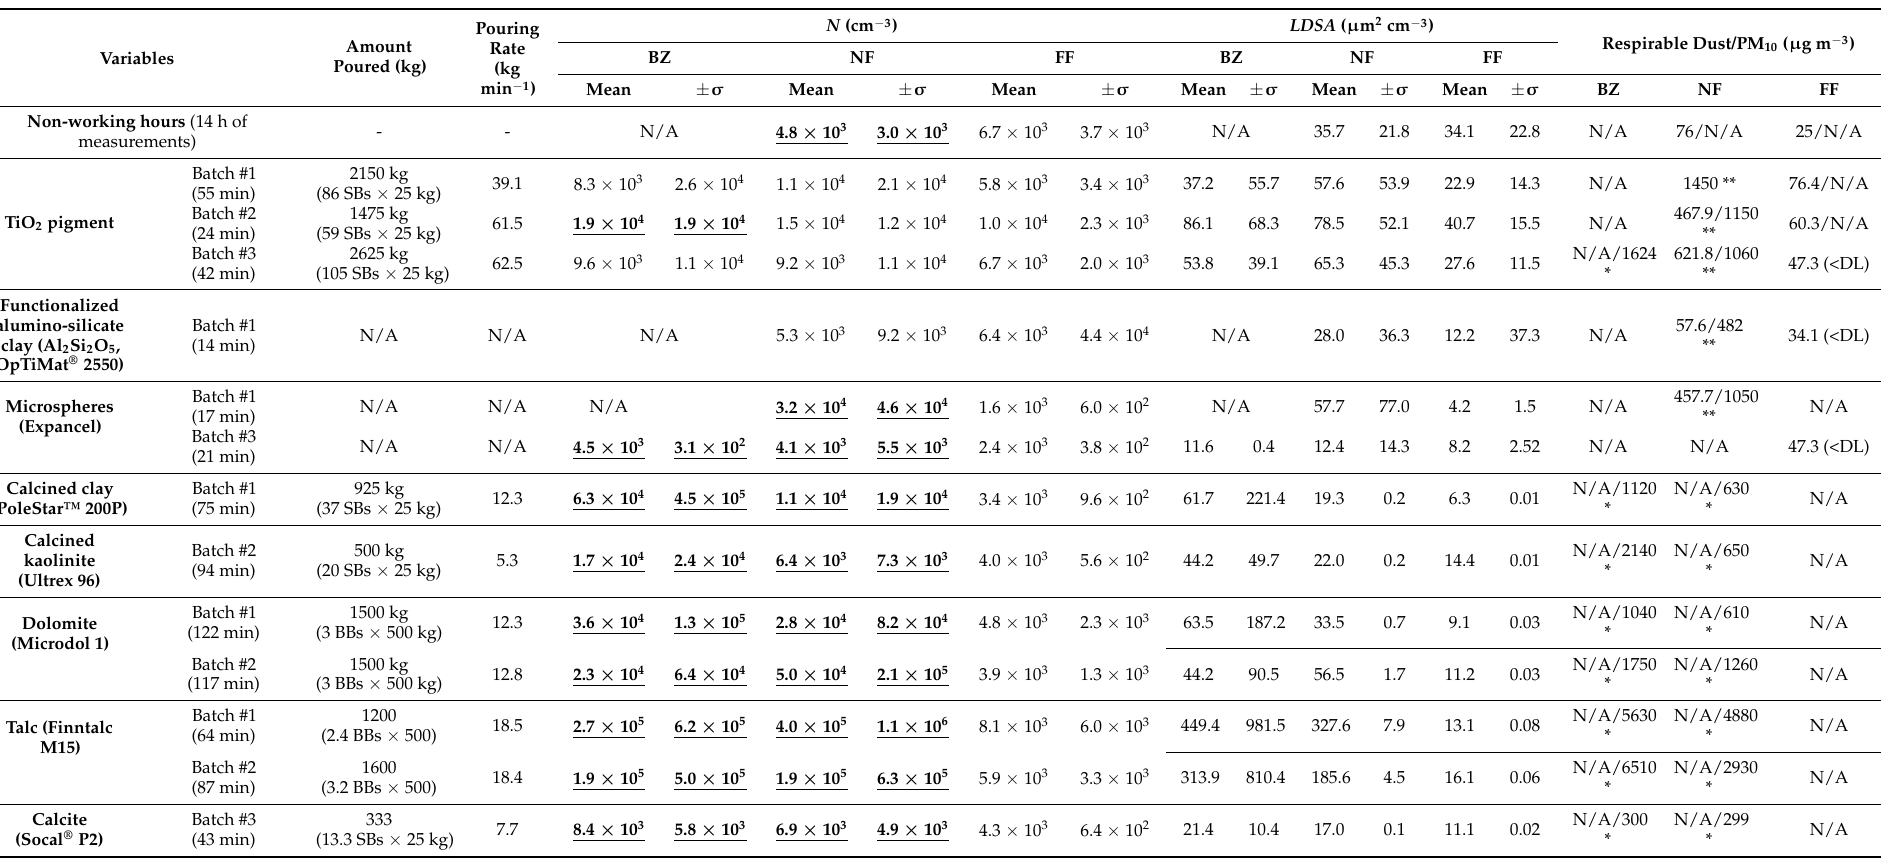
Table 2. Descriptive statistics for the measured particle number concentrations ( N ), and lung deposited surface area (LDSA) by using DiSCmini (DM) (size range 10–700 nm) for non-working hours and for each poured material during each batch production and respirable dust and PM 10